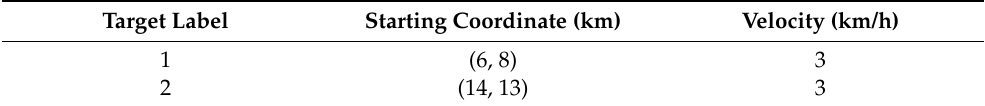
Table 3. Initial target information.